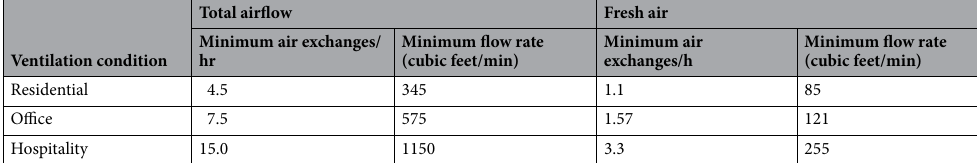
Table 1. American Society of Heating, Refrigeration and Air-Conditioning Engineers Inc. ventilation